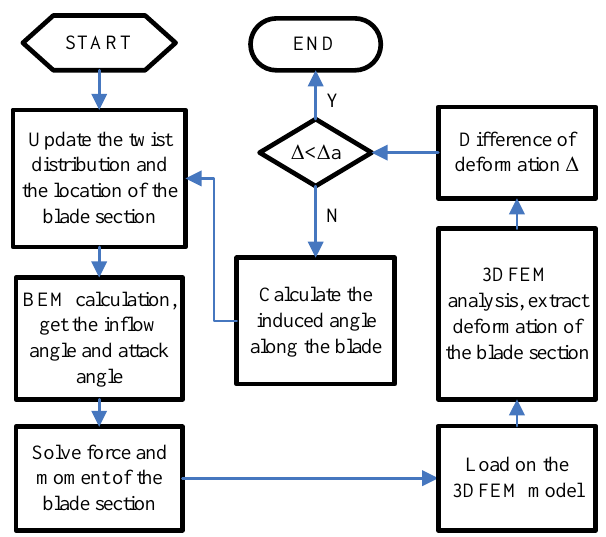
Figure 3. Flow chart of the BEM-3DFEM model.